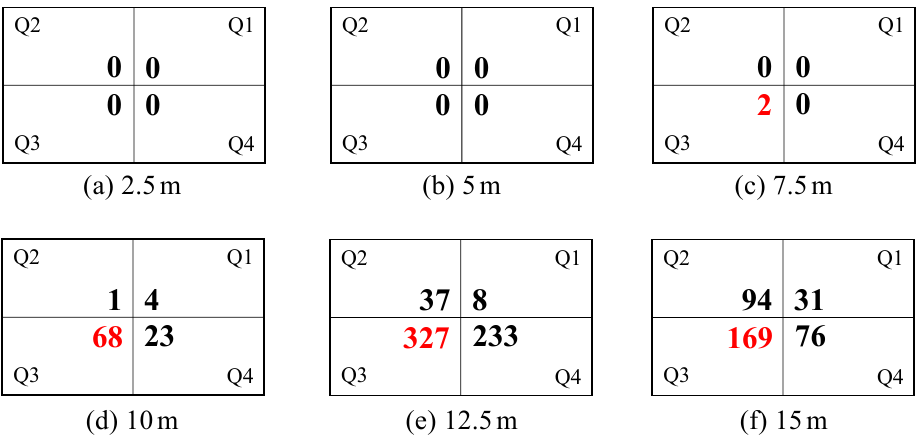
Figure 7. Number of freezes detected in the four quadrants for different distances between transmitter and